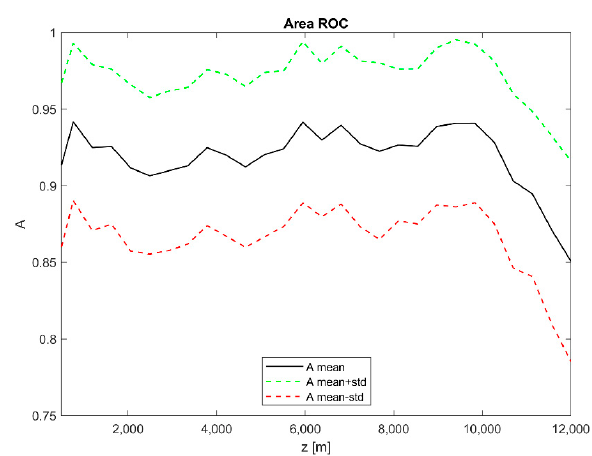
Figure 14. Calculated A, the area below ROC, in dependence on elevation above the radar site (z [m]). The figure shows mean values of A (black solid line) and mean A ± standard deviation of A (dashed lines).